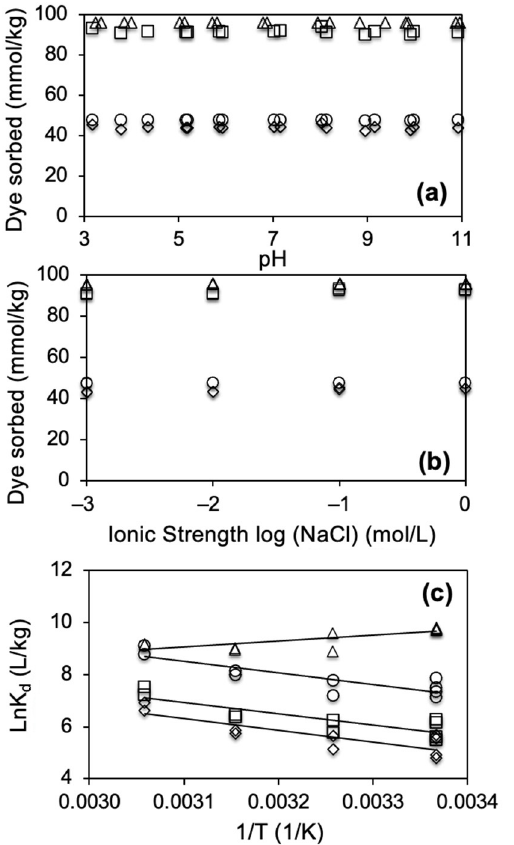
Figure 4. Influence of equilibrium solution pH ( a ), ionic strength ( b ), and temperature ( c ) on dye sorption. See Figure 3 for symbol legends.